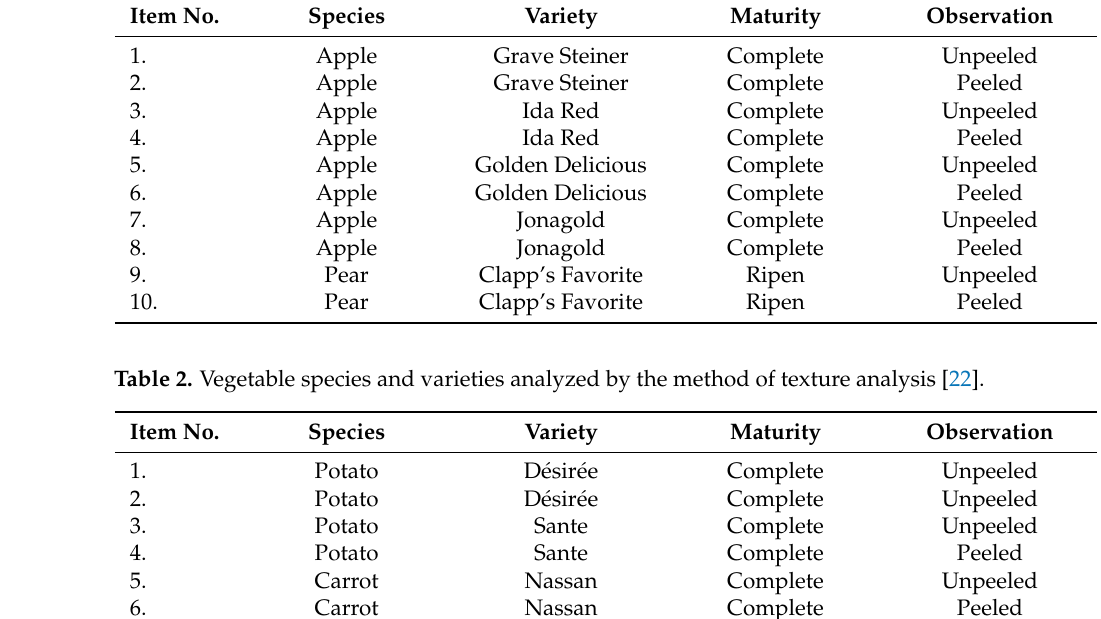
Table 2. Vegetable species and varieties analyzed by the method of texture analysis [22]. Item No. Species